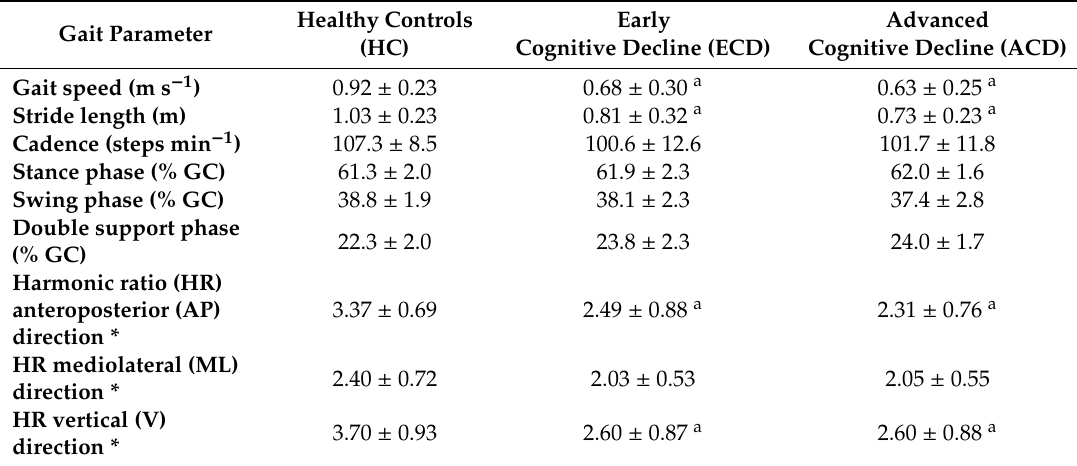
Table 2. Spatio-temporal and smoothness-of-gait parameters calculated for the three groups of elderly. Values are expressed as mean ± SD.